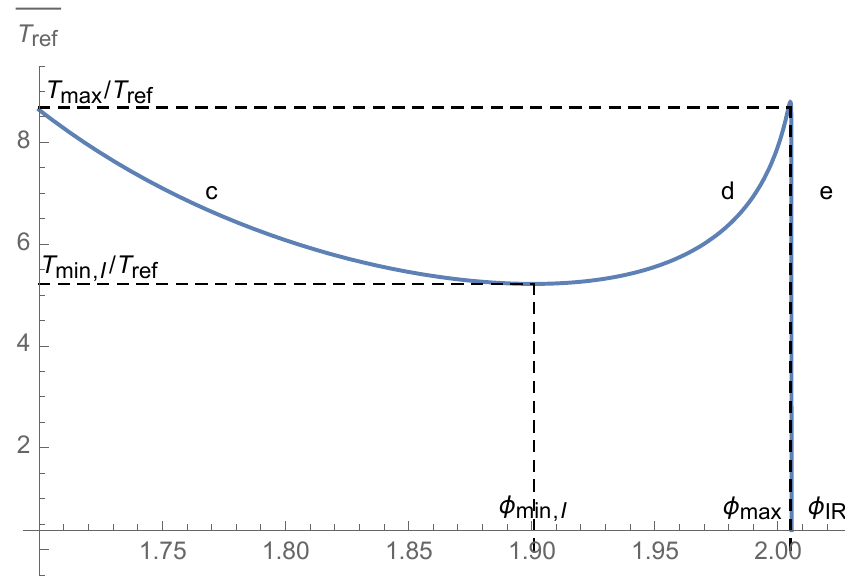
Figure 22 . Blowing up the (cid:12)gure 21 at very small temperatures reveals existence of there di(cid:11)erent blackhole solutions for T (cid:12)xed between a T min ; I and a T max .